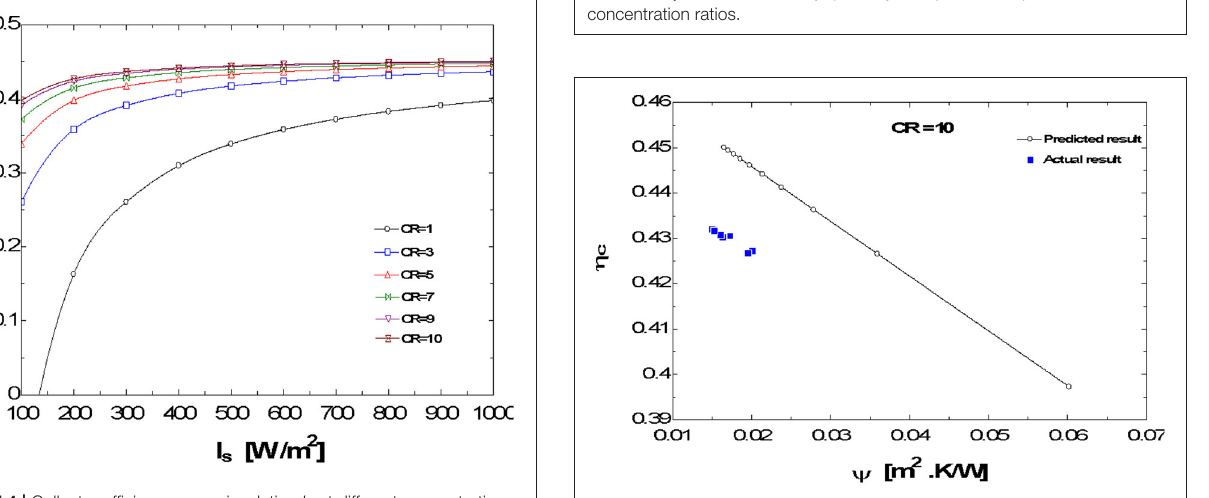
FIGURE 6 | Collector efficiency η c vs. system parameter ψ at CR =